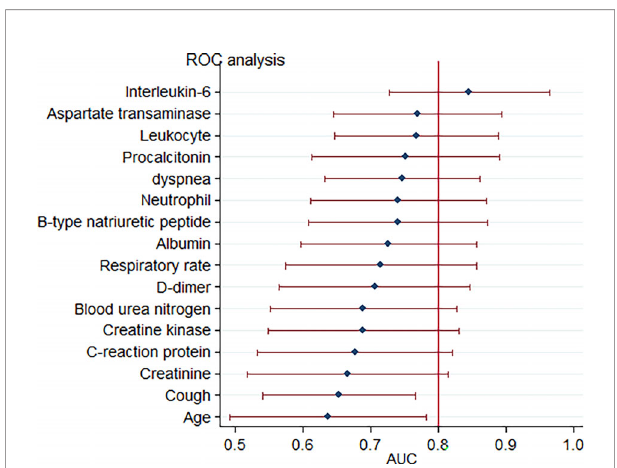
FIGURE 3 | Forest plot for accuracy of various markers in predicting critical COVID-19-related pneumonia. Each marker is plotted as an area under the curve of the receiver operating characteristic curve (AUC) with a 95% con fi dence interval.